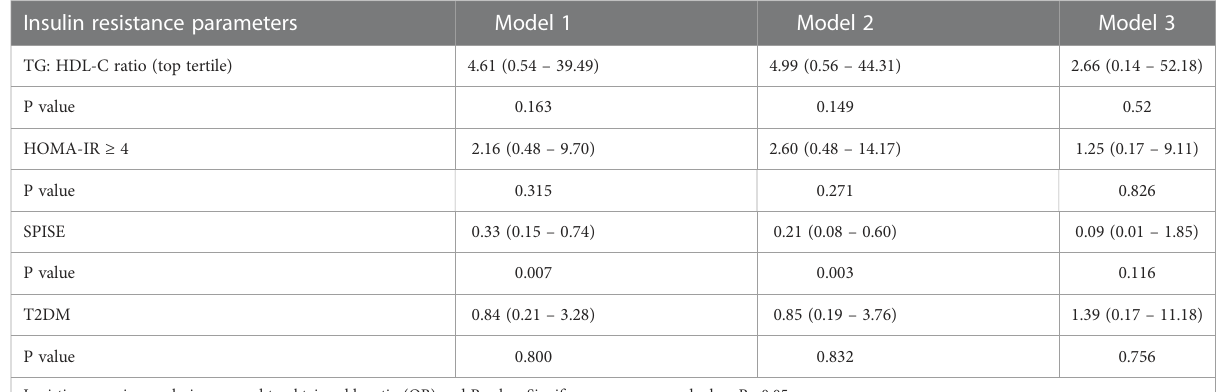
TABLE 2 Odds ratio of insulin resistance parameters and T2DM for liver steatosis in overweight and obese children and adolescents. Insulin resistance parameters